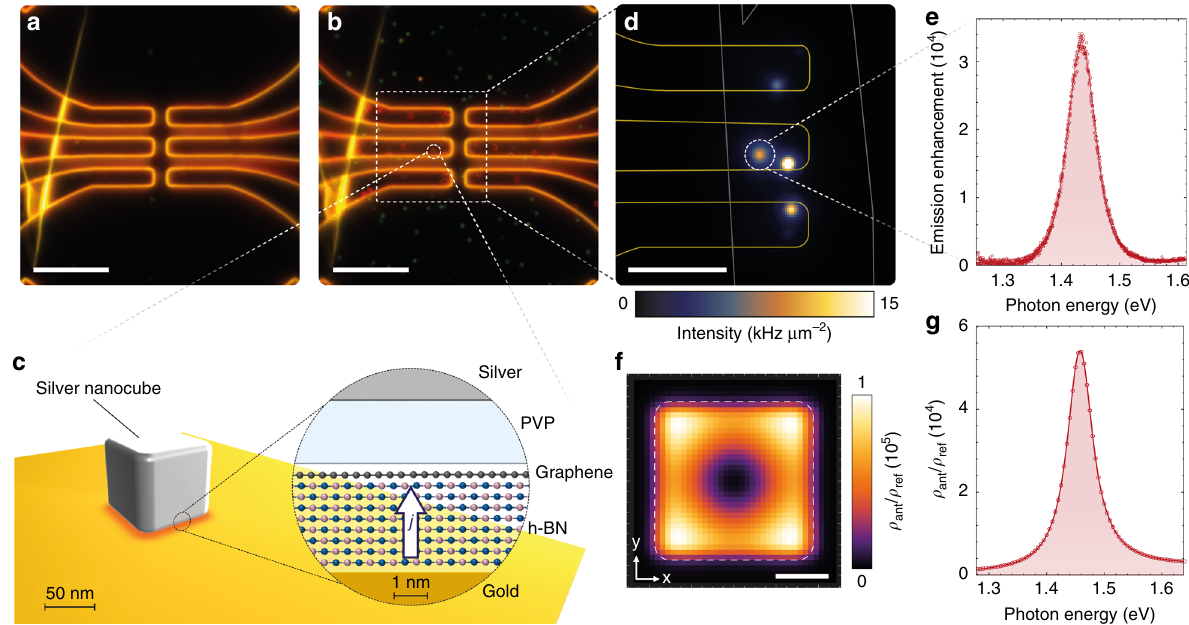
Fig. 5 Nanocube antennas driven by a vdWQT device. a Dark fi eld microscope image of the same devices as shown in Fig. 2a. Scale bar: 10 μ m. b Dark fi eld image after the deposition of silver nanocubes onto the sample. The red ring-like patterns on top of the electrodes indicate the presence of nanocube antennas. Scale bar: 10 μ m. c Schematic illustration of the nanocube antenna con fi guration. The inset shows a vertical cross-section of the modi fi ed heterostucture con fi guration which determines the optical modes “ seen ” by tunneling electrons. d Spatial intensity distribution of light emission from nanocube antennas. Outlines indicate the spatial location of the edges of graphene and gold electrodes. Scale bar: 5 μ m. e Emission spectrum of the antenna marked by a dashed circle in d at V b = 2 V, normalized by the corresponding emission spectrum of the planar heterostructure (Fig. 4a). f Spatial (on resonance) and g spectral dependence of the simulated, radiative fraction of the optical mode density of the nanocube antenna ρ ant for a vertically oriented dipole located in the center of the h-BN crystal, normalized by the radiative LDOS of the planar geometry ρ ref , cf. Supplementary Note 4. The white dashed line in f marks the outline of the silver nanocube (75 nm with a 7.5 nm edge